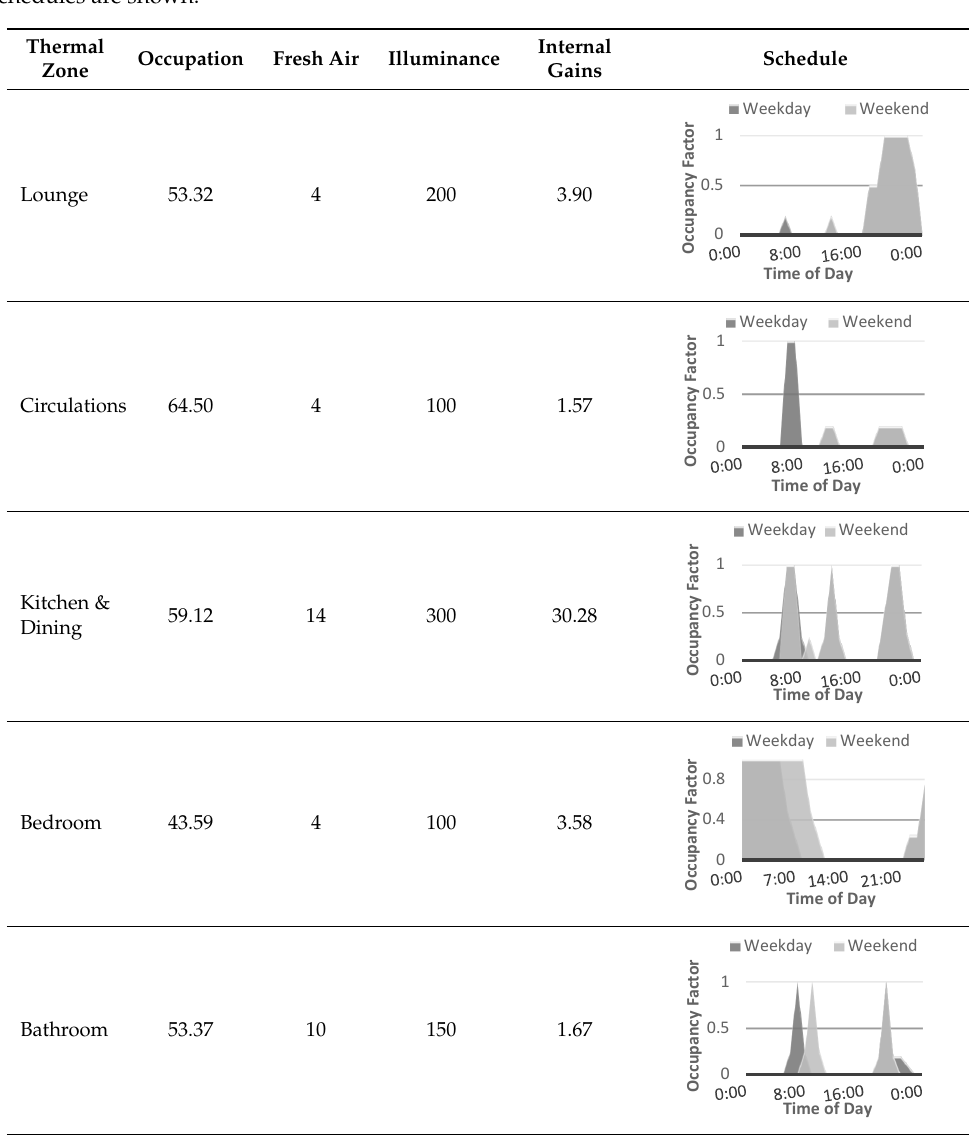
Table 2. Input parameters set for the simulations. The occupation density (m 2 /person), the minimum fresh air (l/s-person), the target illuminance (Lux), the internal gains (W/m 2 ) and the occupation schedules are shown.